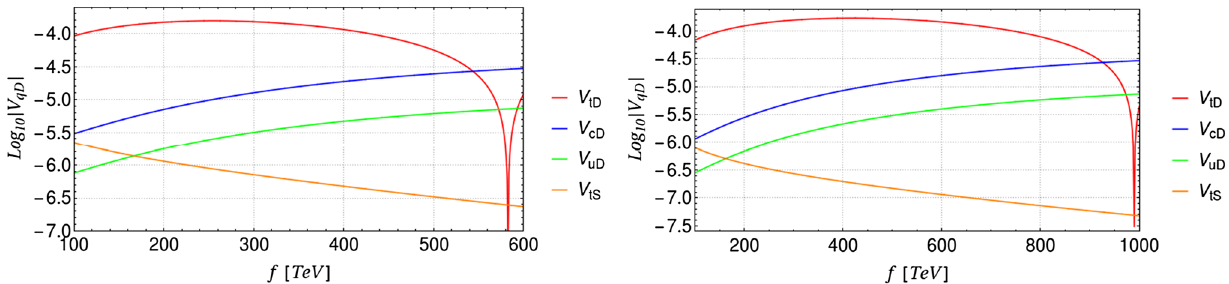
Fig. 2 The four largest quark mixing matrix elements between the VLQs and up-type SM-like quarks. In these plots s = 10 TeV and ω = 100 TeV while on the left p = 600 TeV and on the right p = 1000 TeV. The f -scale varies between the limiting ω – f and the p – f compressed